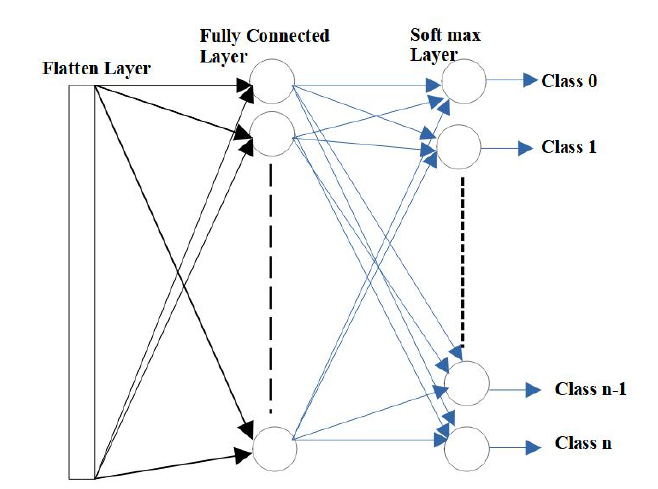
Figure 5. Fully connected layer